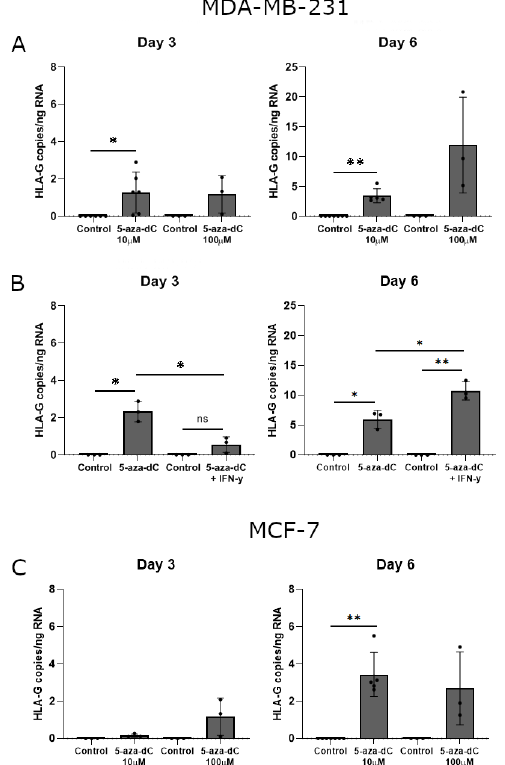
Figure 6. HLA-G mRNA expression in stimulated breast cancer cell lines. The effect of 5-aza-dC on the transcriptional level of HLA-G was determined by ddPCR and presented as number of HLA-G copies per amount of RNA. ( A ) MDA-MB-231 cells treated with 10 μM or 100 μM 5-aza-dC for three and six days. ( B ) MDA-MB-231 cells treated with a combination of 10 μM 5-aza-dC and 30 ng/mL IFN-γ for three and six days. ( C ) MCF-7 cells treated with 10 μM or 100 μM 5-aza-dC for three and six days. Shown are mean ± SD, each dot represents one sample. * p < 0.05, ** p < 0.01 (Student’s unpaired t -test with Welch’s correction).